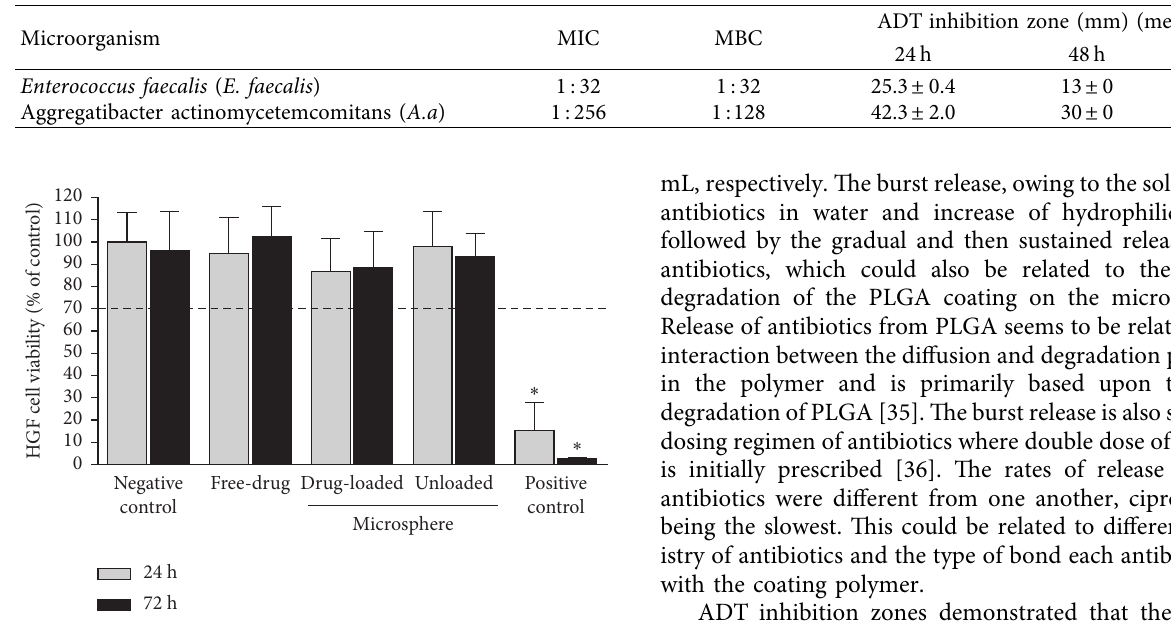
Figure 6: Cell viability percentage of treated HGF cells compared to untreated HGF cells (negative control; no cytotoxicity; 100% viability). Positive control: water-treated HGF cells (severe